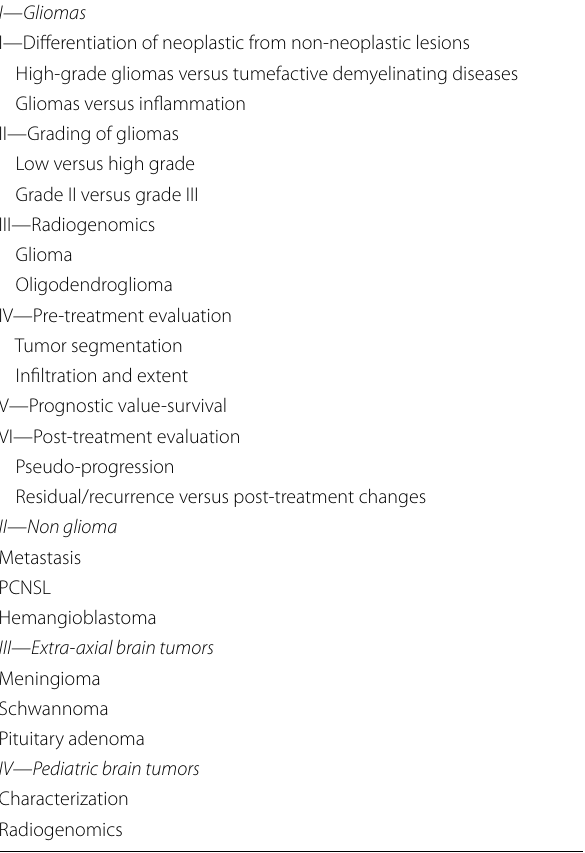
Table 1 Clinical application of AI in